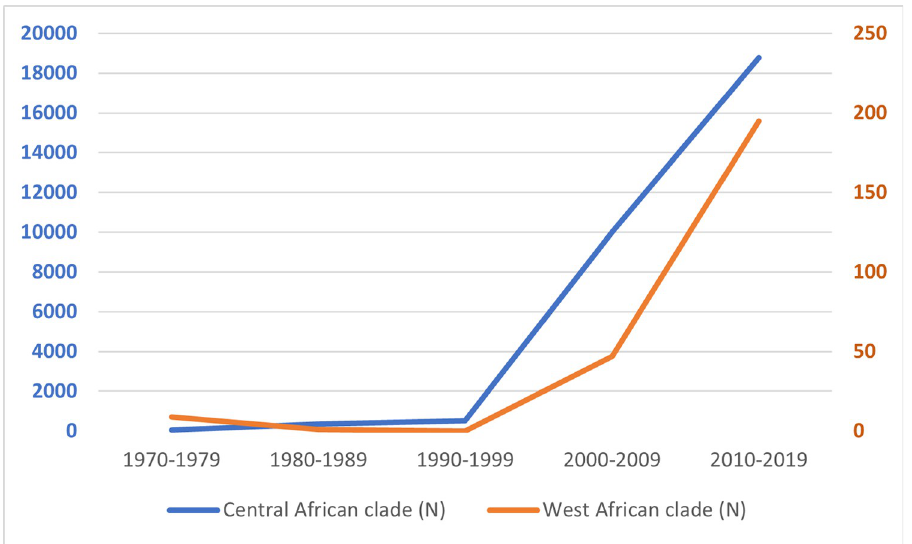
Fig 7. Evolution of number of cases per clade. For 2000–2019, the numbers for the Central African clade are based largely on suspected cases, per the reporting system by the Democratic Republic of the Congo.